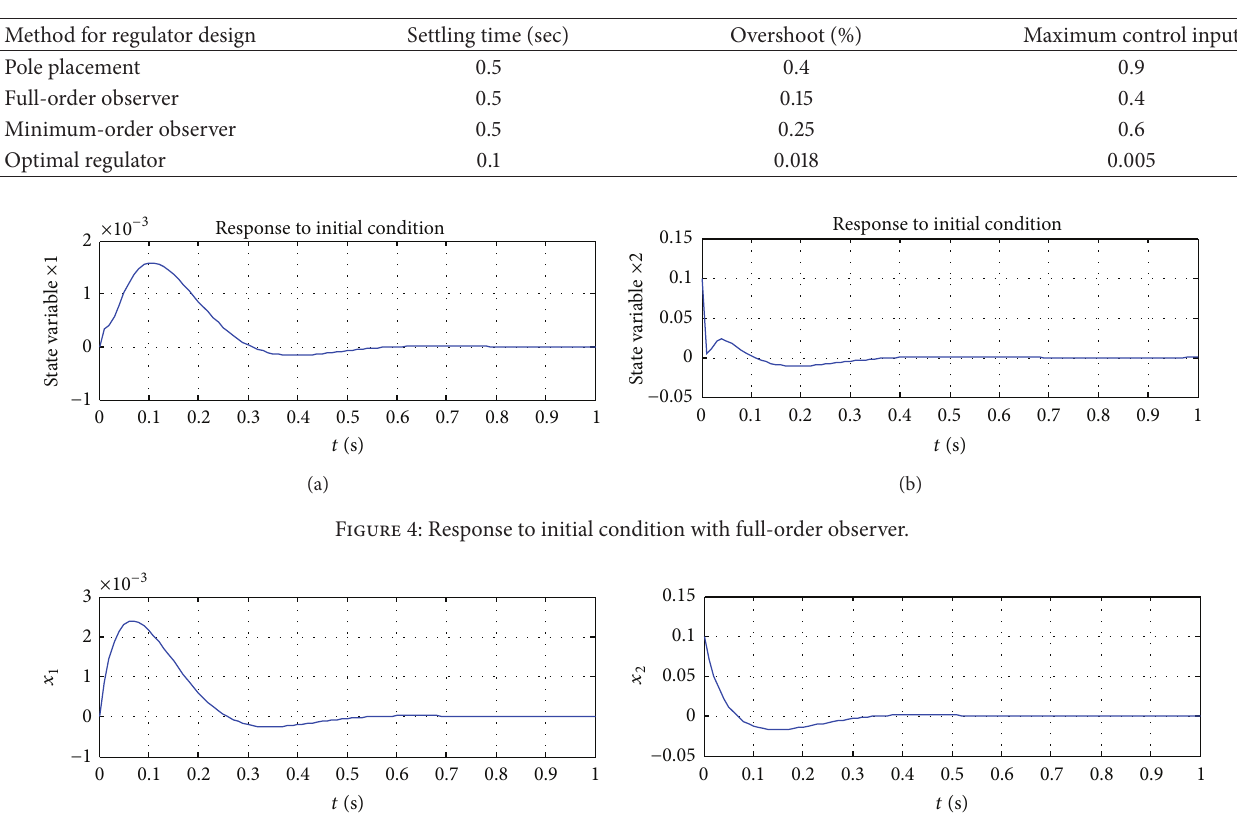
Table 2: Settling time, overshoot, and maximum control input of the response to initial condition of the valve.